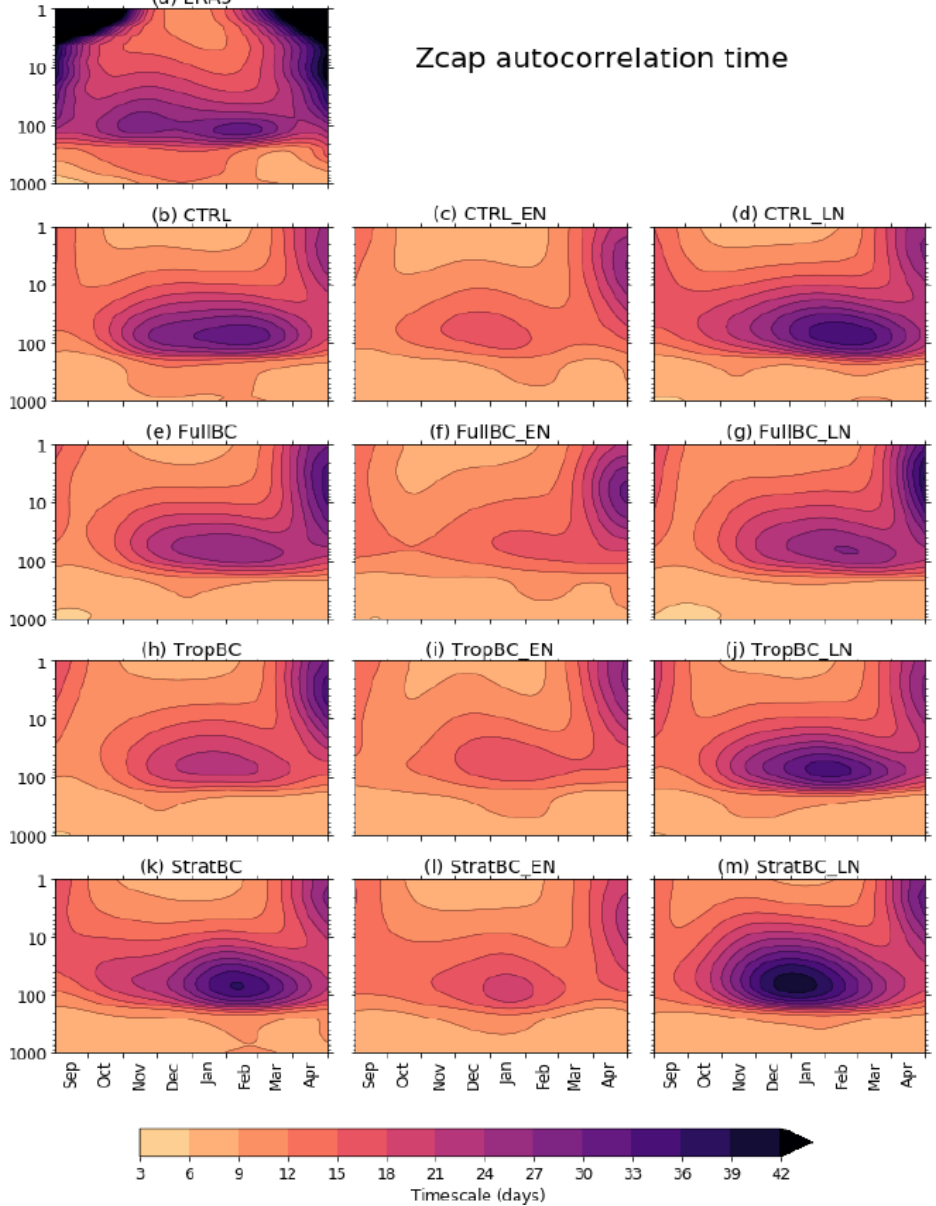
Figure 2. Timescales of polar cap (60–90 ◦ N area average with cosine weighting) geopotential height ( Z cap ) variability. The timescales are defined as days when the autocorrelation function drops to 1 /e . The time series are smoothed in time with a Gaussian filter ( σ = 26d), following Fig. 1 from Baldwin et al. (2003). ERA5 data from 1979–2019, 100 years for each model run (neutral, El Niño, and La